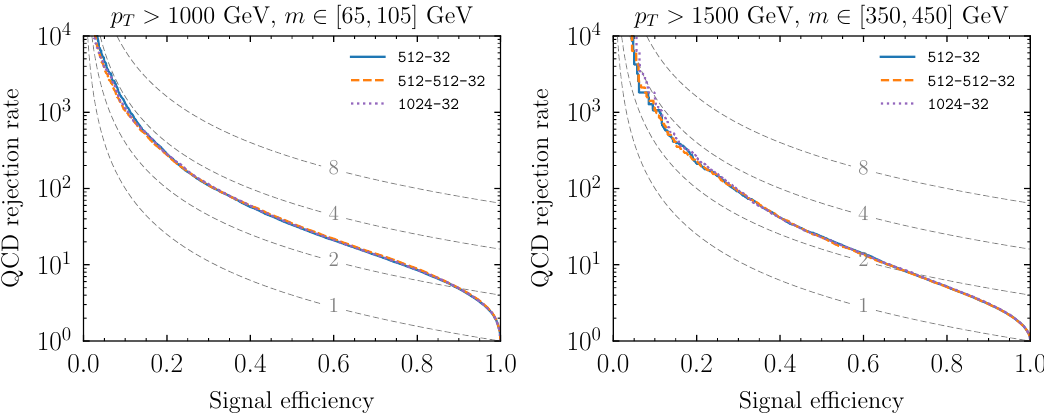
Figure 10 . Performance of the taggers for di(cid:11)erent network architectures.